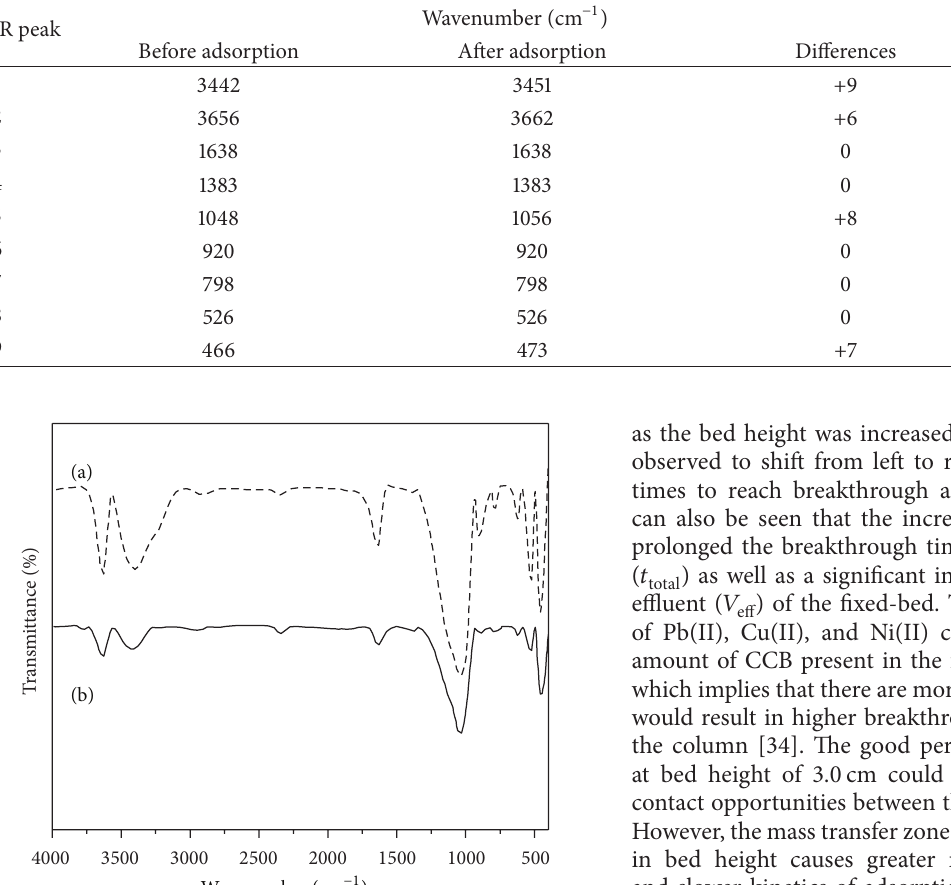
Table 1: FTIR analysis of CCB (before and after adsorption).